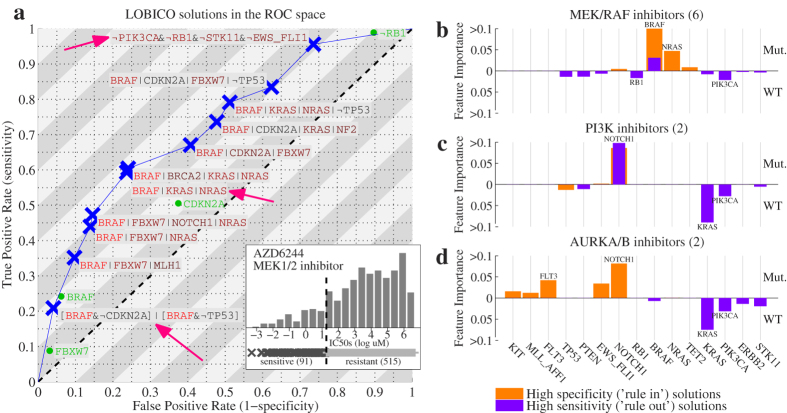
LOBICO finds solutions at different operating points.(a) ROC space with LOBICO solutions to explain drug sensitivity to the MEK1/2 inhibitor AZD6244. Blue crosses indicate the TPR and FPR at which the solution was found. The logic formula of the solutions is printed next to the blue crosses. The color of the genes in a formula indicate their FI. Colors range from black (moderately important) to bright red (highly important). For comparison, the best single predictor solutions are visualized in green. Pink arrows point to solutions discussed in the text. The inlay depicts the histogram of IC50s for AZD6244 together with the binarization threshold, which divides the cell lines into 91 cell lines that are sensitive to AZD6244 and 515 that are resistant. (b) Average FI scores for a group of 6 MEK/RAF inhibitors (including AZD6244), for high specificity solutions (orange) and high sensitivity solutions (magenta). High specificity solutions were defined as solutions with FPR < 10%. Conversely, high sensitivity solutions were defined as solutions with TPR > 90%. The FI scores of all solutions on the Pareto front (ROC curve) that met these respective criteria across the six drugs were averaged. We distinguished between positive terms, indicating mutations (Mut.) and negated terms, indicating wild-type (WT). The two genes with the highest average FI score as mutants were printed at the top of their FI bar. The two genes with the highest average FI score as wild-types were printed at the bottom of their FI bar. (c,d) Similar to (b), but for a group of two PI3K inhibitors and a group of two AURKA/B inhibitors, respectively.